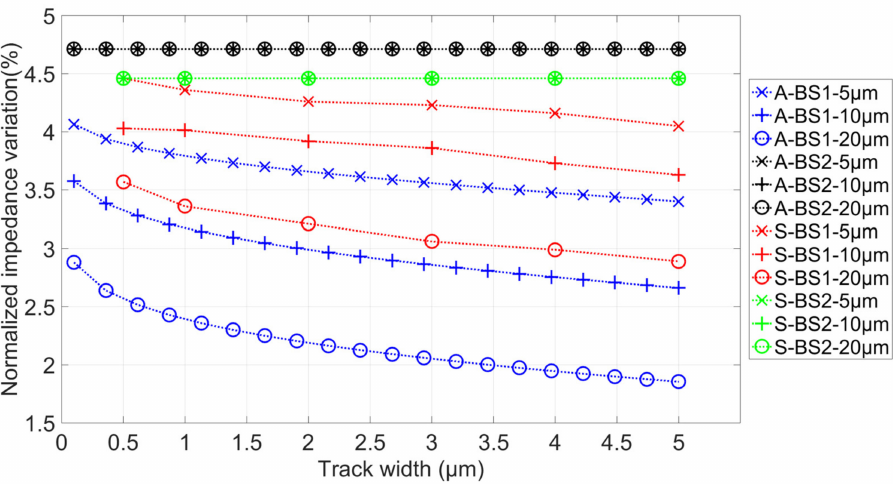
Figure 4. Normalized impedance variation as a function of track width for three di ff erent connection length (5 µ m, 10 µ m, and 20 µ m), with and without an insulated layer. “A” corresponds to analytical calculation, and “S” to FEM simulation results. Green and black curves are superimposed.